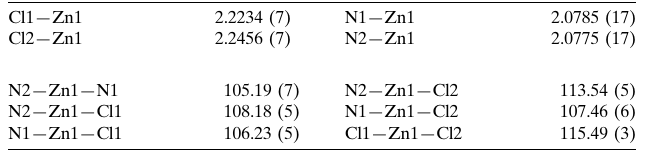
Selected geometric parameters (A˚ , (cid:2) ).